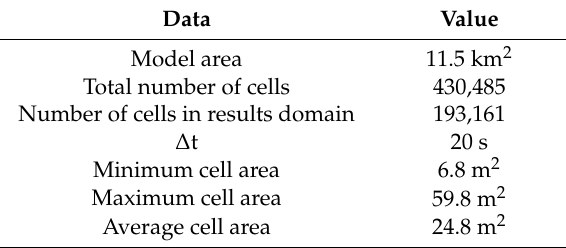
Table 2. 2D hydrodynamic model